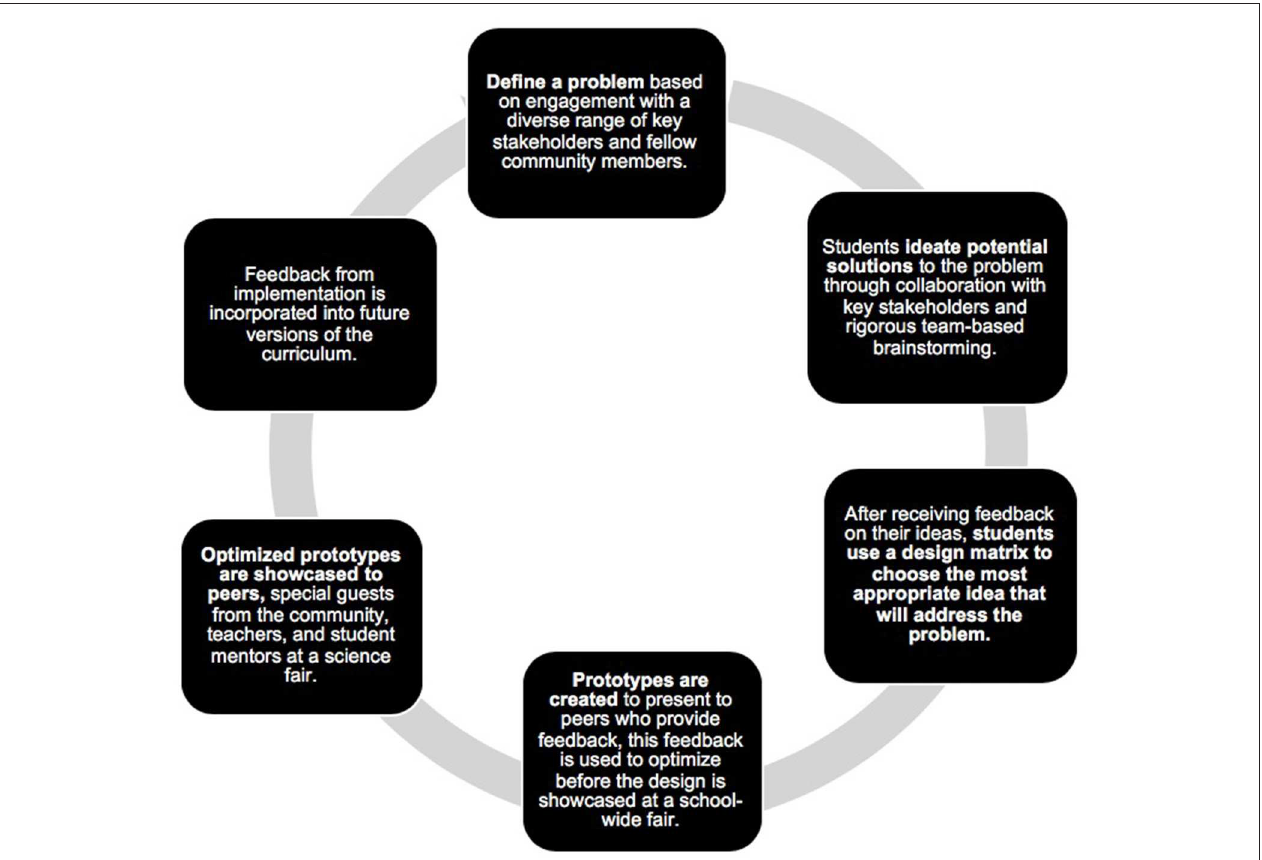
FIGURE 1 | The circular feedback loop of the Ignite